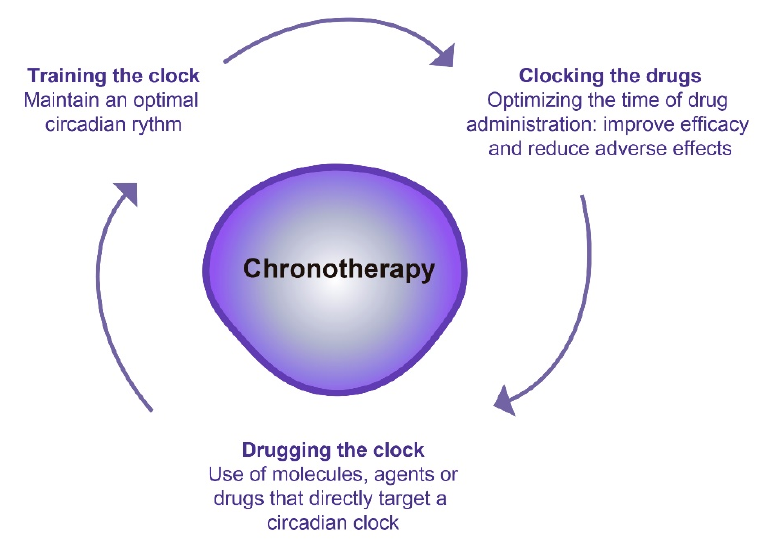
Figure 5. Different chronotherapeutic approaches.